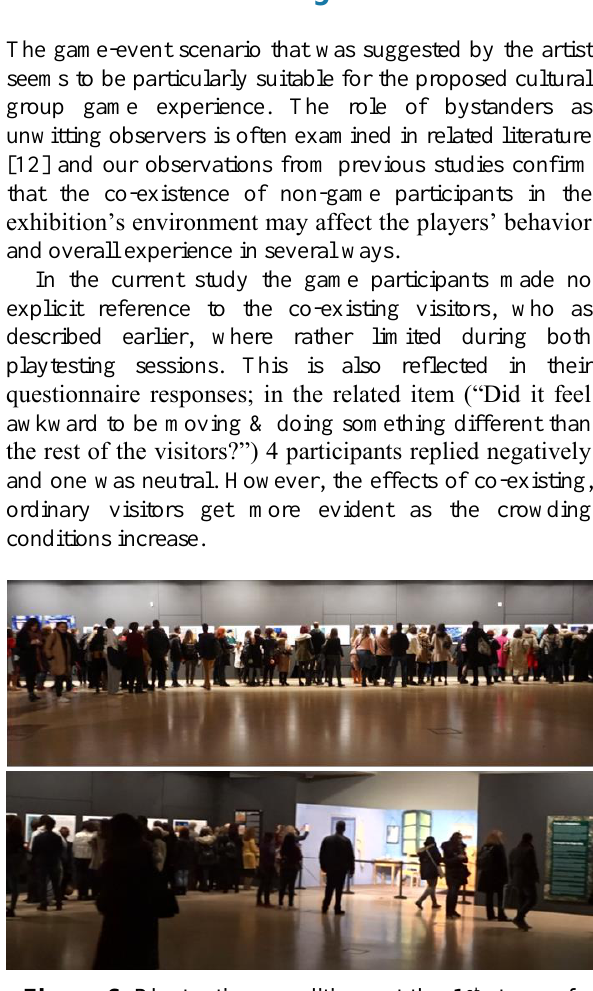
Figure 6. Playtesting conditions at the 1 st stage of the exhibition “Van Gogh Alive – The Experience” (March